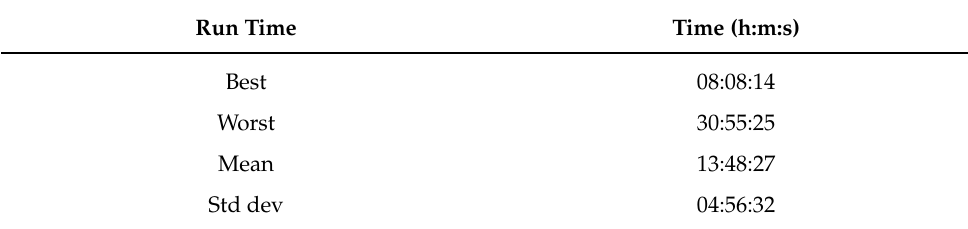
Table 6. Experiments measures: running time for Scenario A1—Greedy.